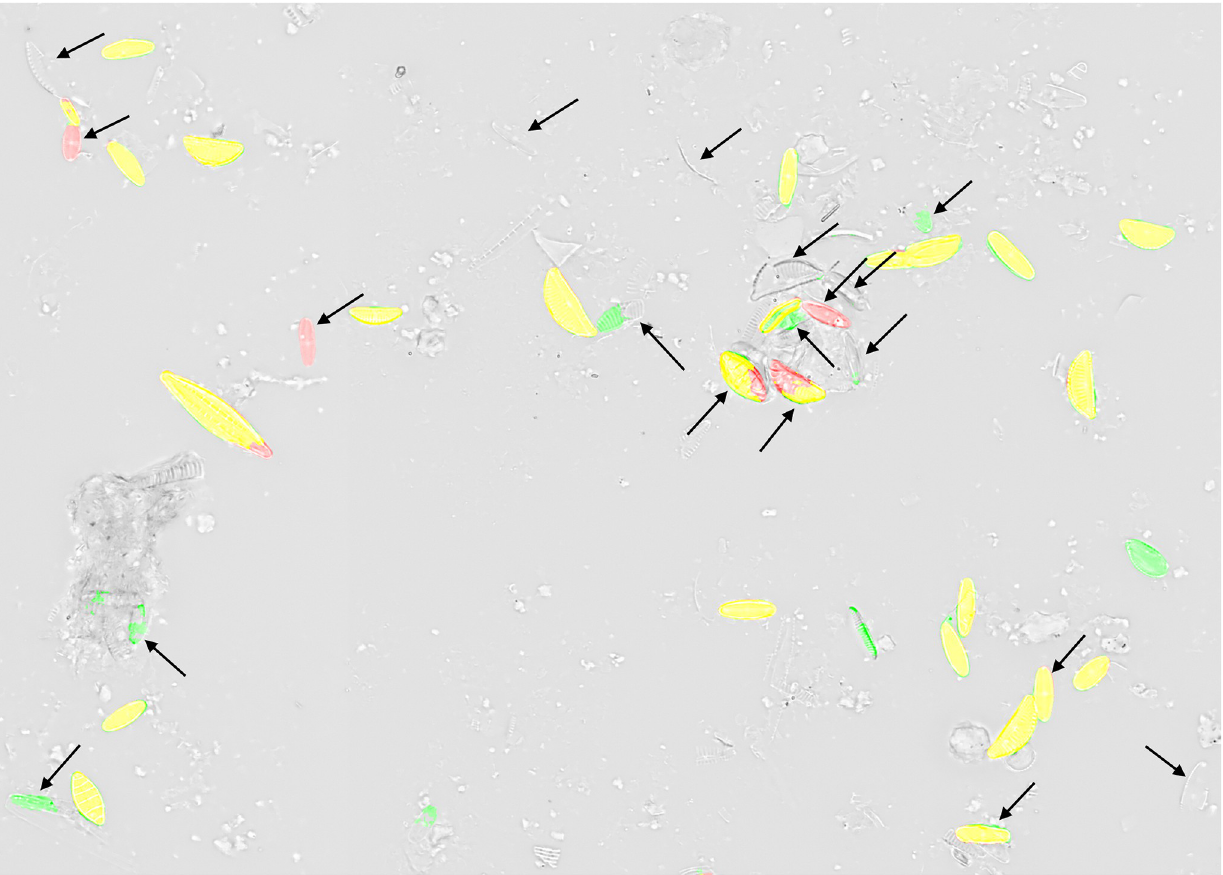
Fig 11. Comparison of predicted segmentation vs. ground truth for a U-Net model (object-based tile positioning + object integrity constraint, 100% training data, prediction score threshold 0.98) on previously unseen test data. Black arrows indicate substantial changes in comparison to Fig 10 (same prediction score but Mask R-CNN model). Yellow = true positive, red = false negative, green = false positive.